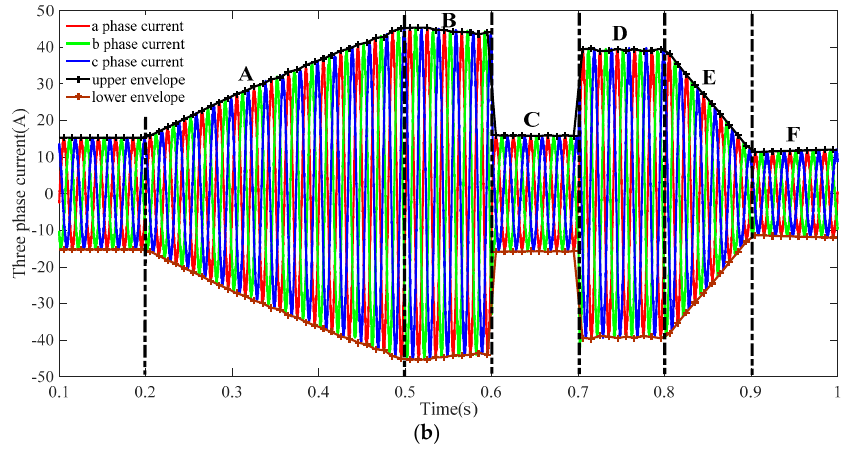
Figure 15. DC-link voltage and inverter output current: ( a ) DC-link voltage; ( b ) Three-phase output current.